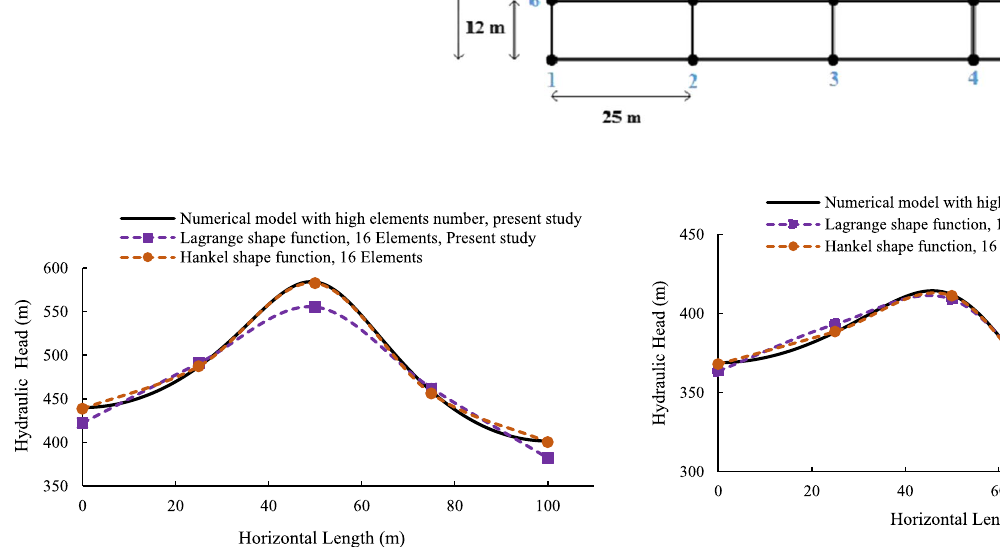
Fig. 12 Comparison of hydraulic head results at y = 0, among Hankel shape function (16 elements) and Lagrange shape function (16 and 5000 elements) for the third problem